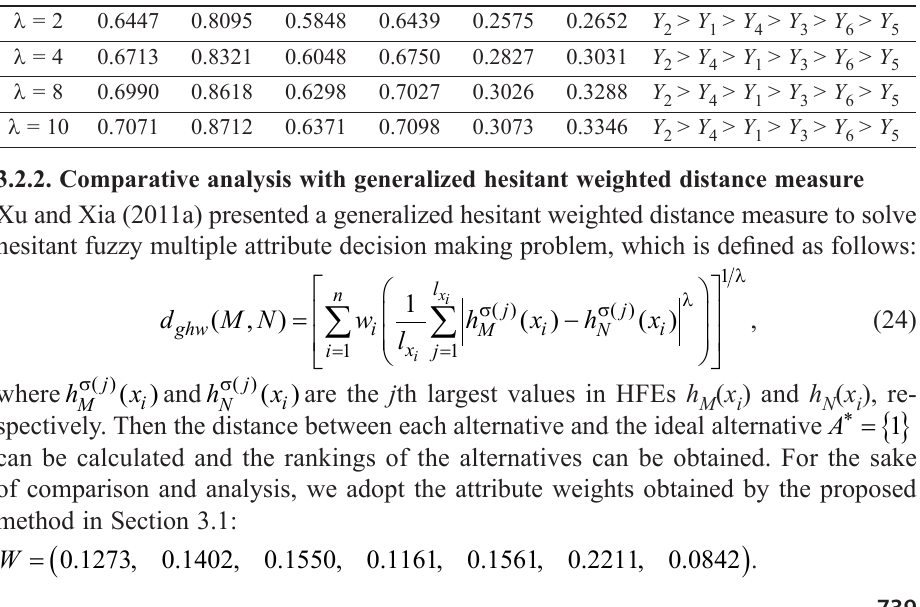
Table 4. Results obtained by hesitant fuzzy distance d